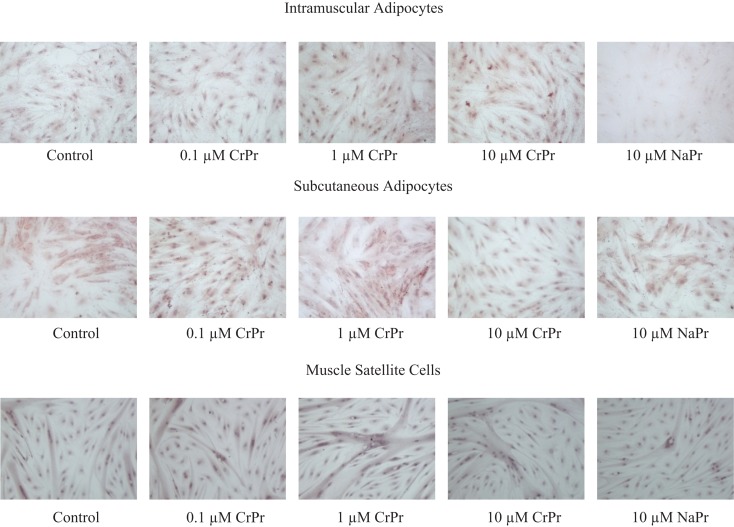
Morphological analysis of dose-dependent treatment of chromium propionate (CrPro) in intramuscular (IM), subcutaneous (SC) adipocyte, and satellite cell cultures at 96 h post treatment. Lipid droplets were stained with Oil-Red-O and nuclei were stained with hematoxylin. Increasing Cr dose on IM adipocytes increases lipid droplet numbers. Lipid droplets increase in SC adipocytes up to 1 μM CrPr. Increasing Cr dose in muscle satellite cells results in increasing muscle fiber size and number.